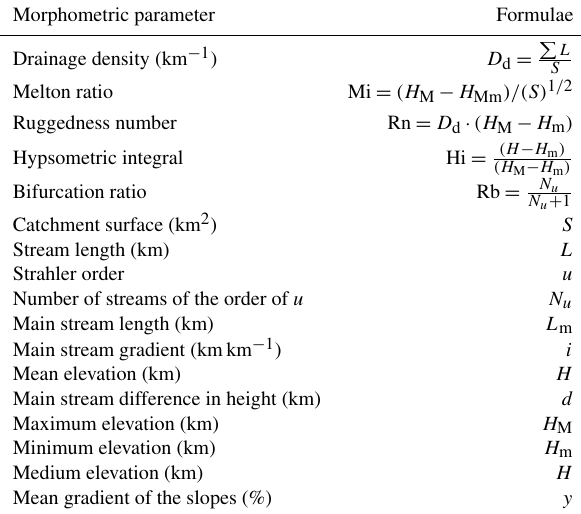
Table 2. The morphometric parameter formulae used. Morphometric